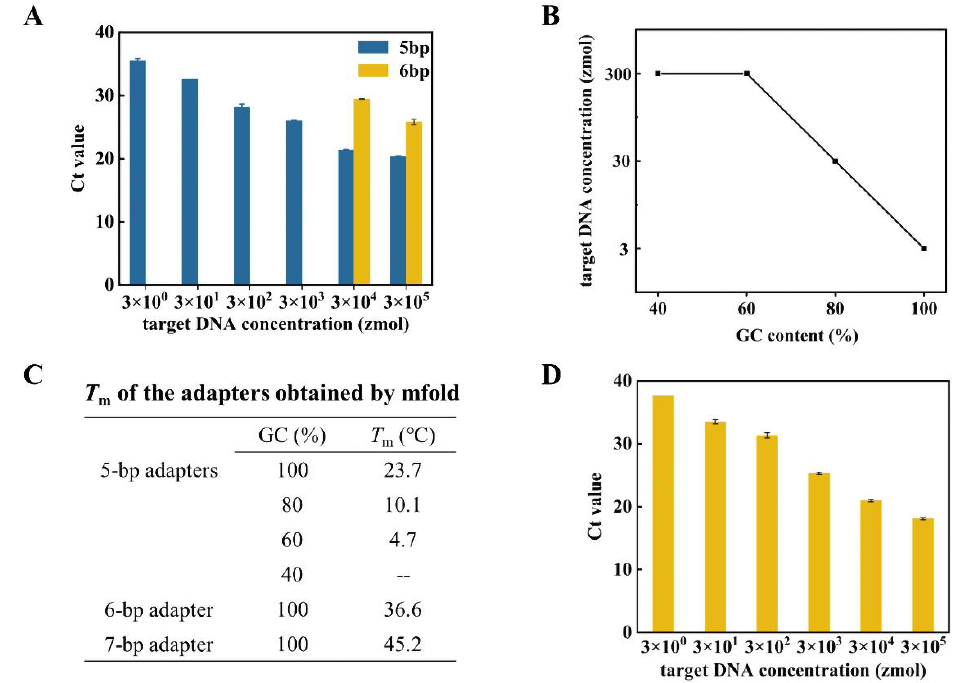
Figure 2. Target cyclization by dynamic adapters. ( A ) Target cyclization by 5-bp and 6-bp adapters with 100% GC content under various concentrations of targets. ( B ) The lowest target concentration that could be cyclized by 5-bp adapters with GC contents of duplex part from 40% to 100%. ( C ) T m values of adapters simulated by Mfold under the conditions of 10 mmol/L Na + and 10 mmol/L Mg 2+ . ( D ) Target cyclization by 5-bp adapter with 100% GC content in the presence of 300 ng oyster genome DNA. Ligation reactions: [adapter] = 10 nM, 2.5 U T4 DNA Ligase at 25 °C for 2 h; qPCR reactions: [primers] = 0.4 μmol/L, 1 μL ligation products, the C t values were the average of three individual